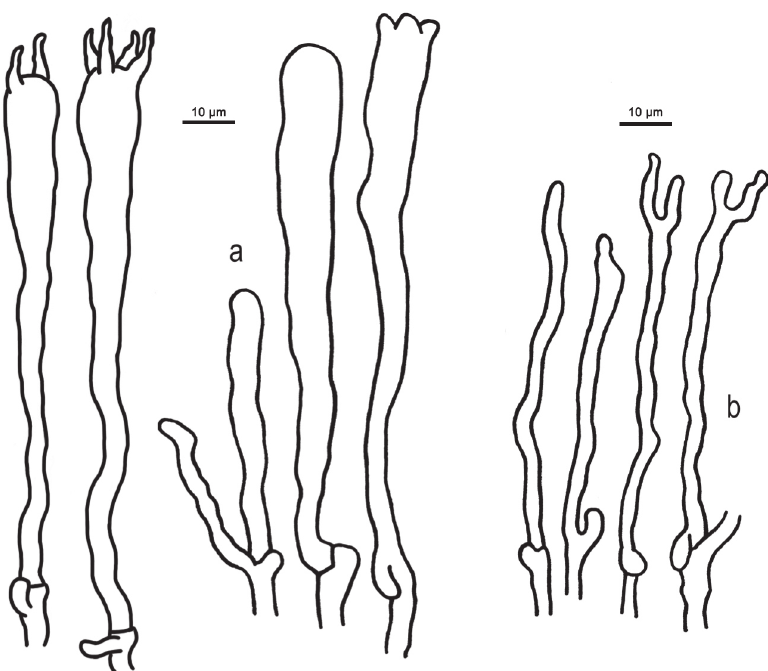
Figure 6. Microscopic features of Clavariadelphus alpinus (HKAS 57396, holotype). a Basidia b Leptocystidia.